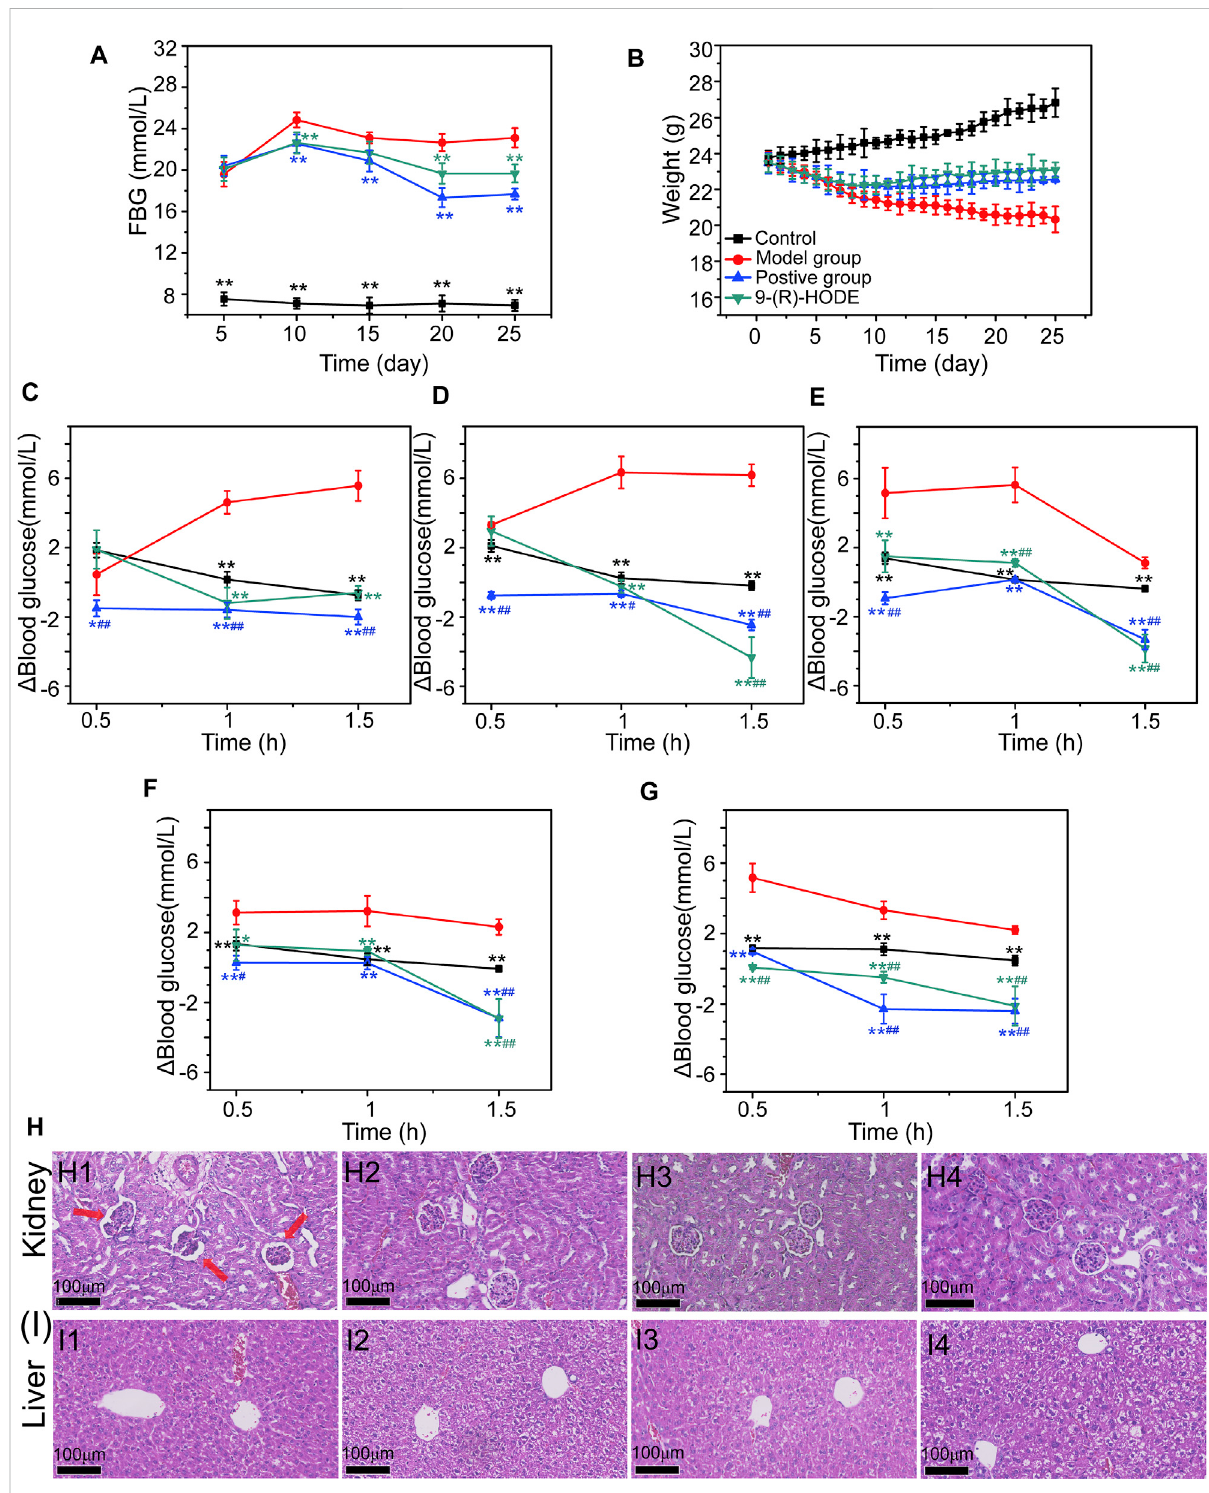
FIGURE 1 (A – B) Effects of 9-(R)-HODE on FBG (A) and body weight (B) . (C – G) Effects of 9-(R)-HODE on PPG tested on Day 5 (C) , Day 10 (D) , Day 15 (E) , Day 20 (F) , and Day 25 (G) . (H,I) Effects of 9-(R)-HODE on kidney (H) and hepatic (I) pathological changes by using the H&E staining method; comparison between the model group (H1, I1), control group (H2, I2), 9-(R)-HODE treatment group (H3, I3) and positive group (H4, I4); *p < 0.05, **p < 0.01, signi fi cantly different from the model group; #p < 0.05, ##p < 0.01, signi fi cantly different from the control